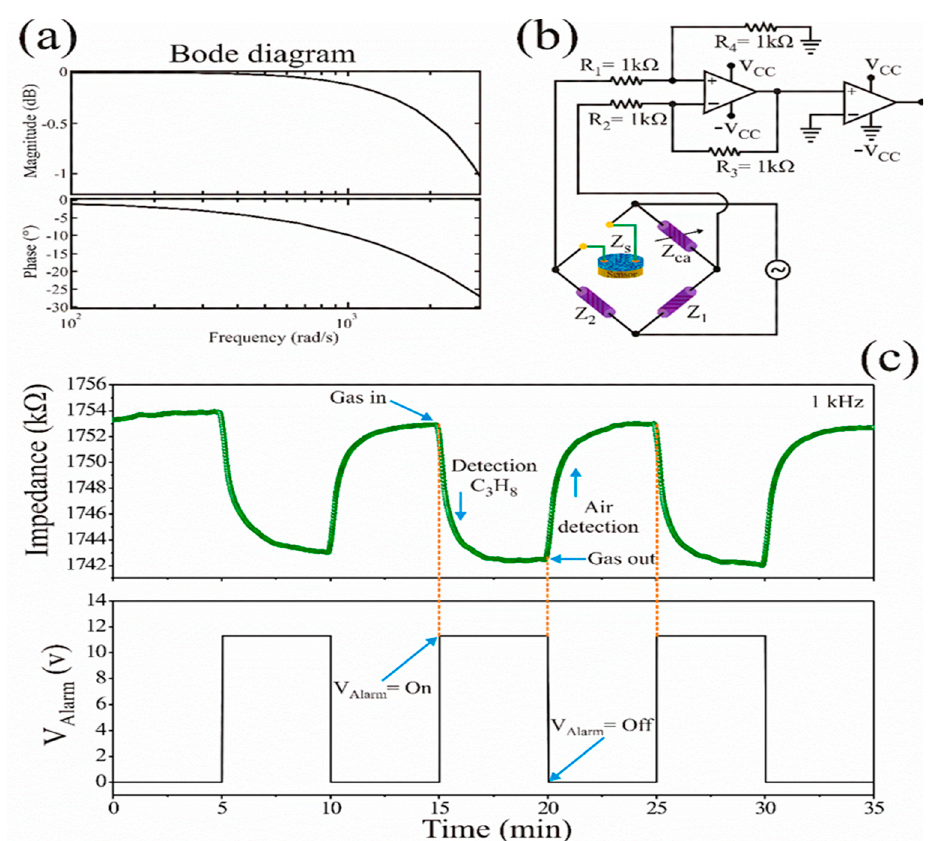
Figure 11. ( a ) Bode diagram of NiSb 2 O 6 pellets’ behavior, ( b ) electronic diagram of the C 3 H 8 -detector, ( c ) detector’s principle of operation.